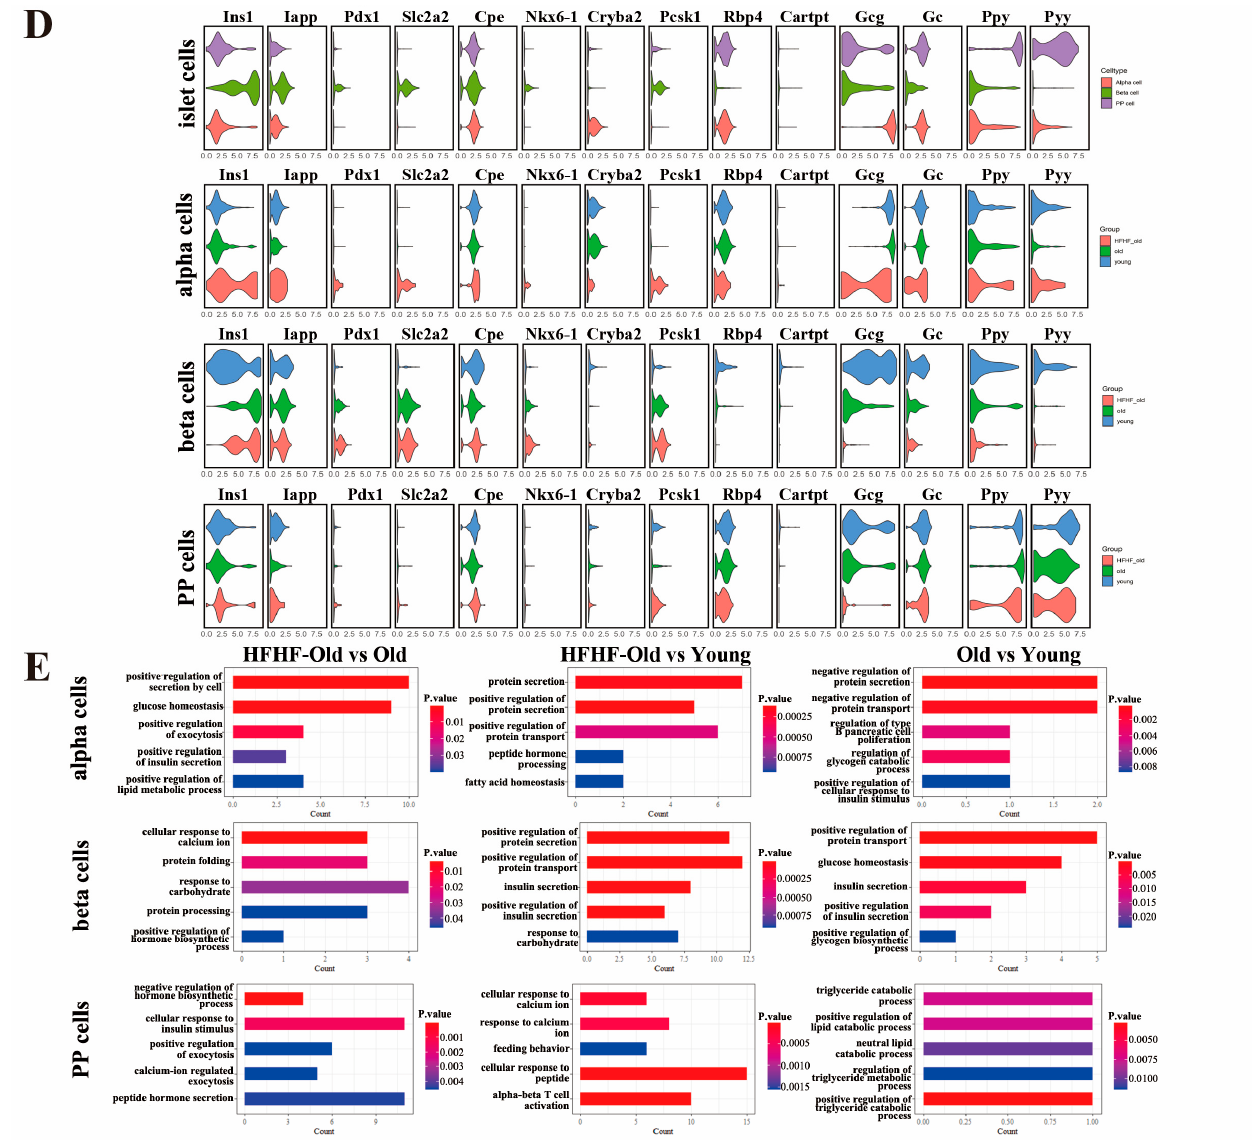
Figure 6 . Distinct cell populations with transcriptional signatures in secreting islet cells. ( A ) UMAP plot characterizing the differences in secretory cell subpopulation distribution at the beginning (young) and after 18 months (HFHF-old, old) of diet feeding. Each point represents one cell. The distance between the two points is determined by the Pearson correlation of the 500 most highly expressed genes in each cell. Cell identity is recognized by the expression of marker genes. ( B ) UMAP plot of the marker gene expression in four types of islet cells. ( C ) The number of different pancreatic secretory cells at the beginning (young) and after 18 months (HFHF-old, old) of diet feeding. ( D ) Violin diagram characterizing the marker genes expression level in islet alpha, beta, and PP cells at the beginning (young) and after 18 months (HFHF-old, old) of diet feeding. ( E ) GO terms of upregulated secretory function-related enrichment obtained in islet alpha, beta, and PP cells after pairwise comparison of three groups ( p <